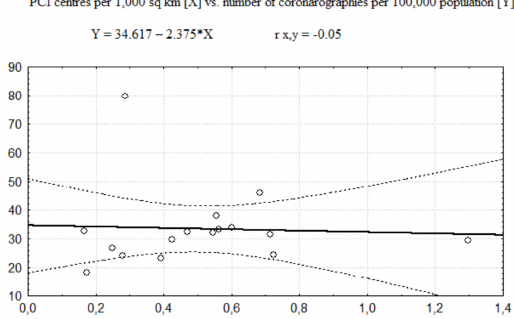
Figure 4. The regression function of PCI centres per 1000 km 2 vs. number of coronographies per 100,000 population.